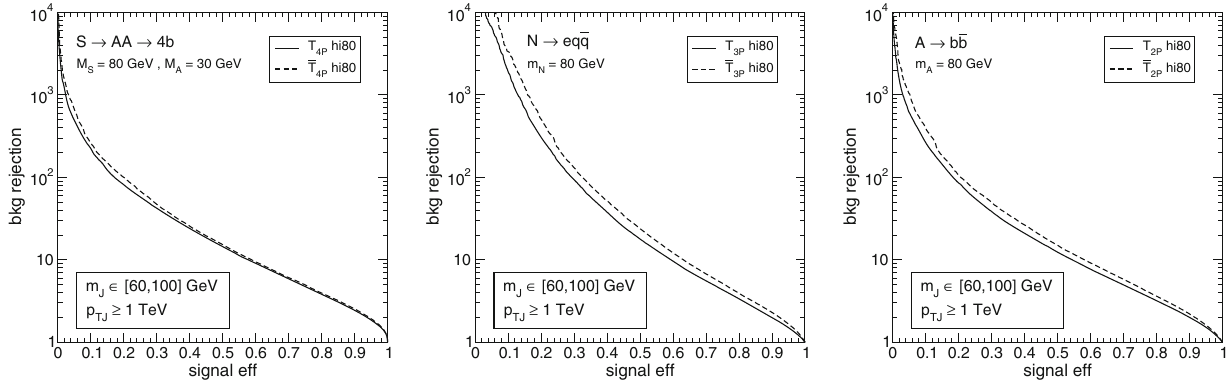
Fig. 10 Performance of the taggers T with mass decorrelation versus the taggers ¯ T directly obtained from the